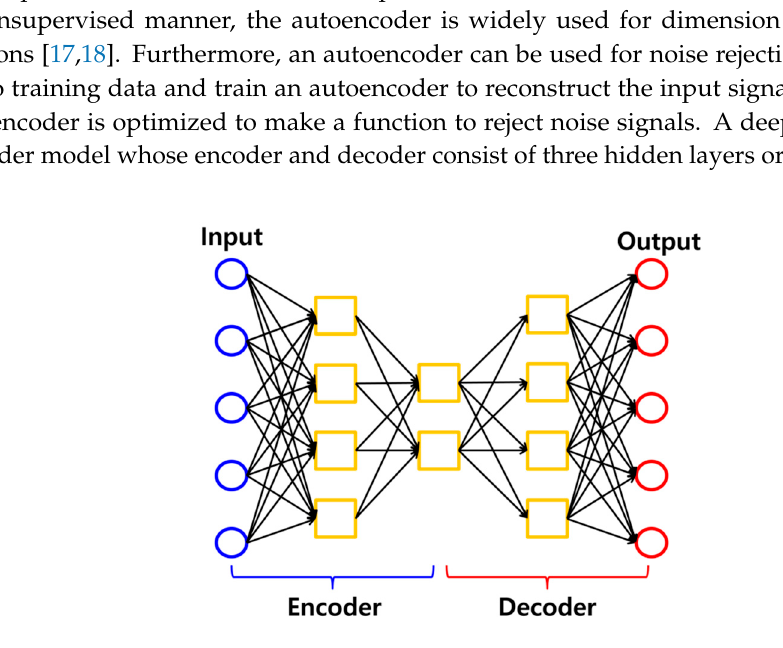
Figure 1. Schematic of autoencoder architecture.